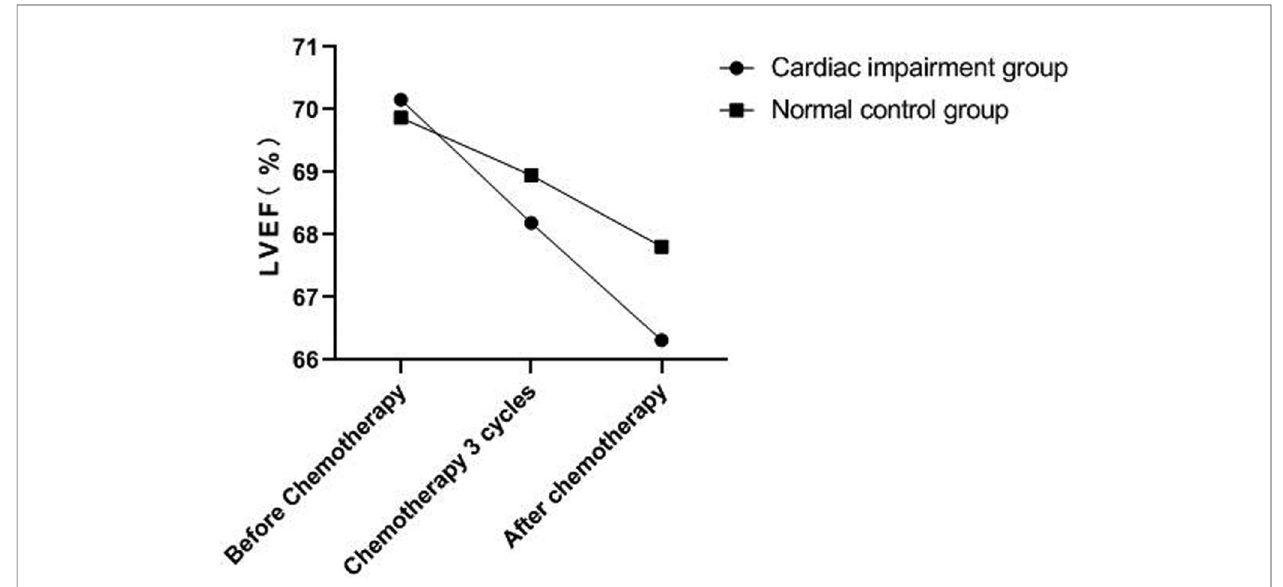
FIGURE 6 | LVEF change trend of patients in two groups.